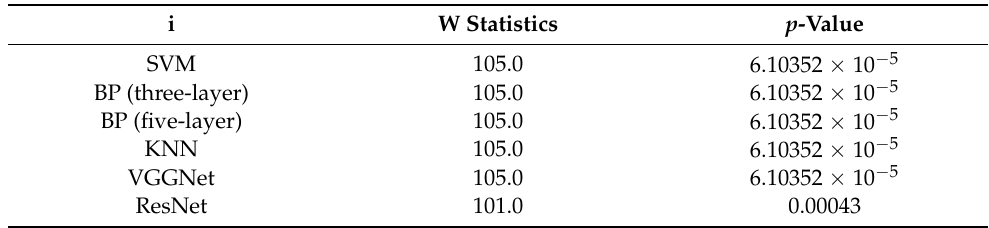
Figure 10. Accuracy of recognition on three datasets (Act-Set, Ref-Set, Avg-Set). The results of the Wilcoxon test are shown in Table 5. Hypothesis H0 in Equation (8) was rejected, and H1 in Equation (9) was accepted. This indicates that the accuracy of recognition of the TSMG model was significantly higher than the other models. There were statistically significant differences in the accuracy of recognition of subjects with different learning styles. This further verifies the design of the proposed model. Table 5. Results of Wilcoxon signed rank